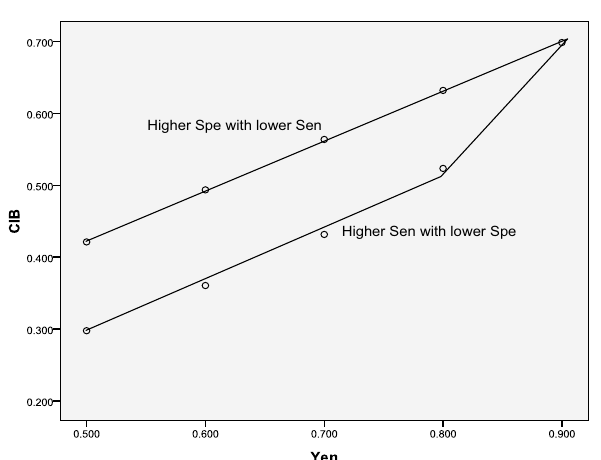
Higher Spe with lower Sen